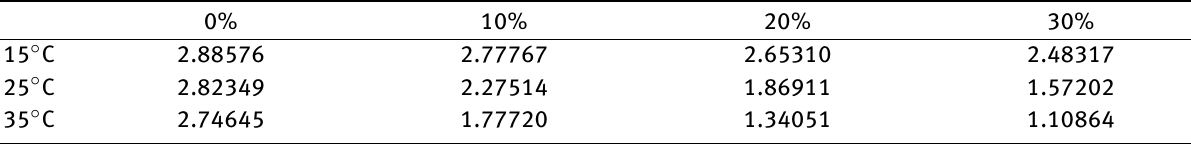
Table 2: ZSV of energetic materials contenting RDX at different temperature ( × 10 6 Pa · s, 1mL/g).